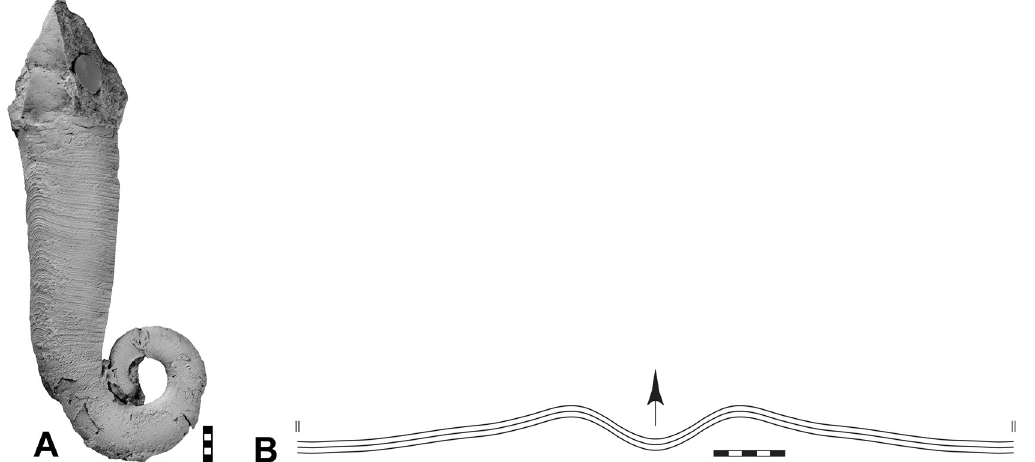
Fig. 29. Holmiceras havelense sp. nov. from the Upper Red Orthoceratite Limestone. A . Holotype MB.C.30526 (Neben & Krueger Coll.) from Werder (Brandenburg); previously figured by Neben & Krueger (1971: pl. 21 figs 2–3). B . Lirae of holotype MB.C.30526 at wh = 14 mm. Scale bar units = 1